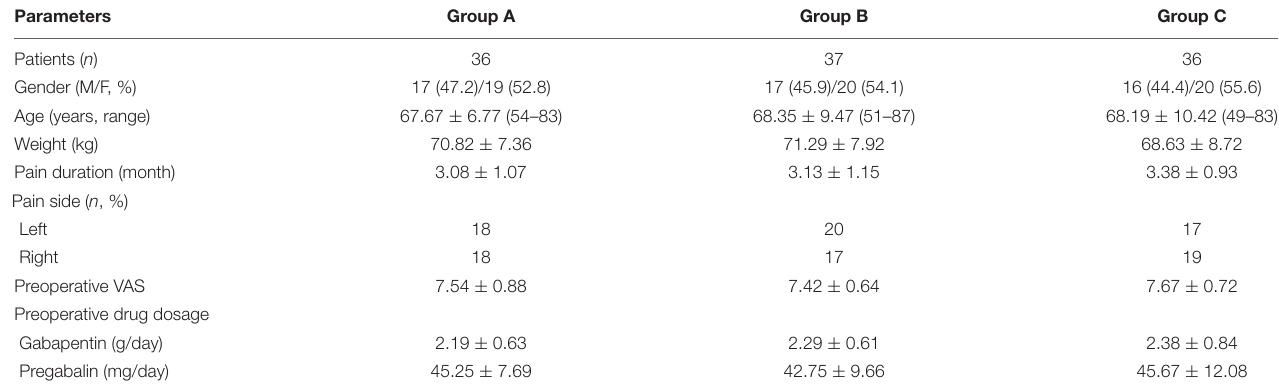
TABLE 2 | Preoperative general characteristics of the patients (mean ±